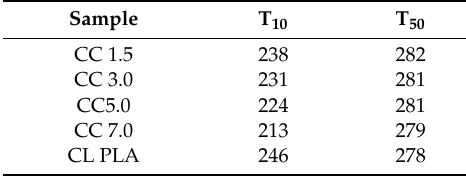
Figure 11. ( a ) TGA thermogram of CL–PLA/CC nanocomposites. [45], Reproduced with permission from Kumar V, Composites: Part B; published by Elsevier, 2014. Table 6. TGA data of CL–PLA/CC nanocomposites. [45], Reproduced with permission from Kumar V, Composites: Part B; published by Elsevier, 2014.